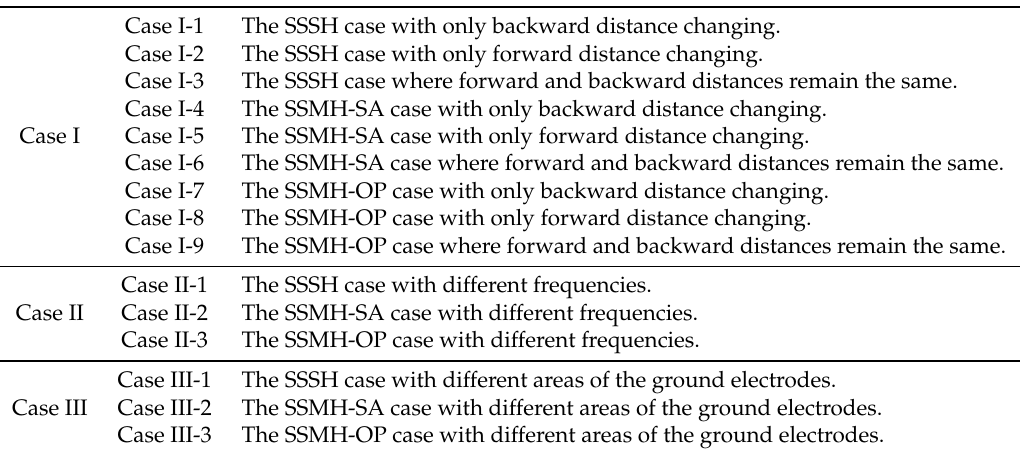
Table 2. Simulation Cases of the S-parameter